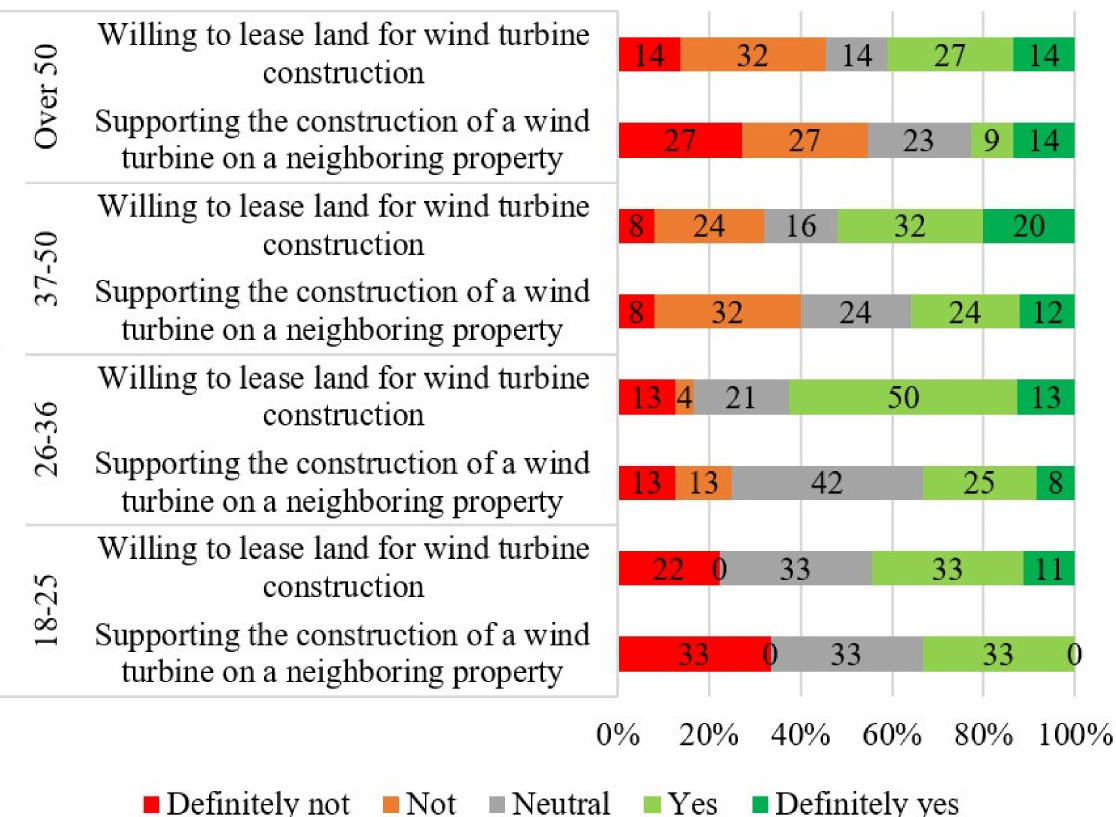
Figure 4. Support for the siting of a wind turbine on an adjacent land plot and the willingness to lease one’s land for the construction of a wind turbine depending on the age of respondents (%). Source: based on own